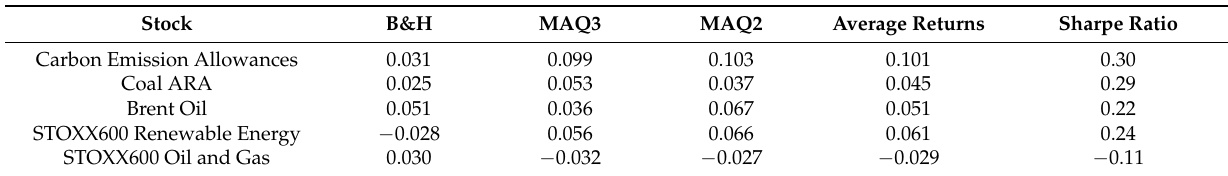
Table A6. Annualized daily (every fourth month) returns of MAQ2–MAQ3 (Q = every fourth month, 3, 2, are the numbers of observations in the rolling window), average returns and Sharpe ratios.